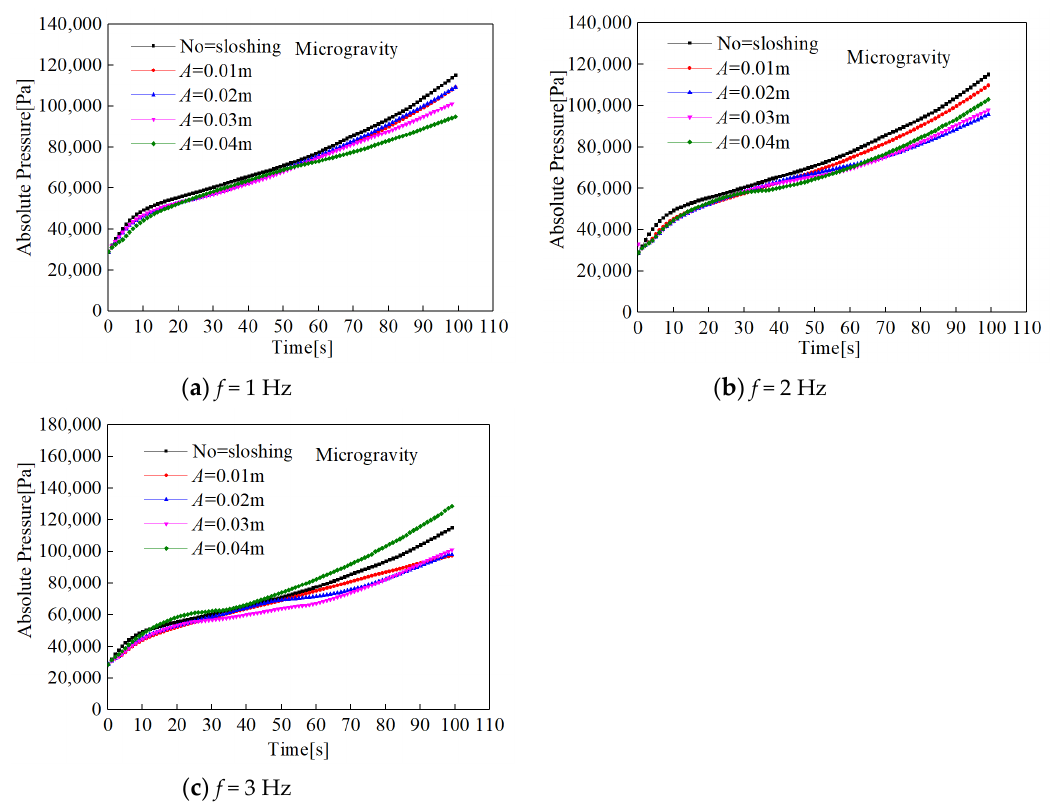
Figure 17. Pressure responses of the no-vent filling process under different sloshing amplitudes and microgravity with the condition of sloshing frequency ( a ) f = 1 Hz, ( b ) f = 2 Hz, and ( c ) f = 3 Hz.